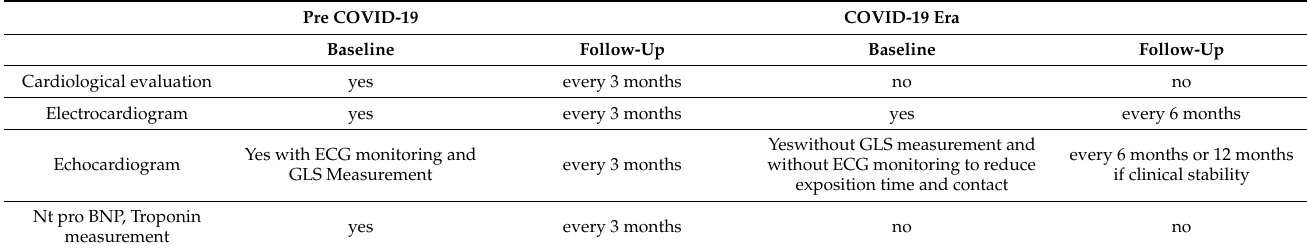
Table 2. Cardiological follow-up in pre COVID-19 era and in the COVID-19